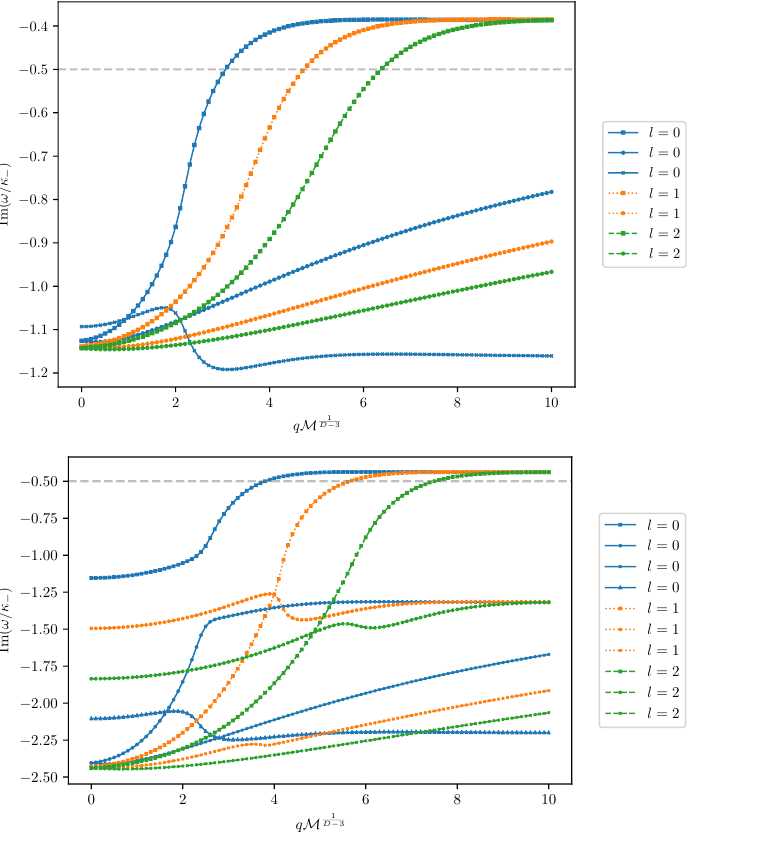
Figure 3 . The imaginary part of the low-lying quasinormal modes for (cid:3) the top is for and Q = 0 : 996 and the bottom is for Q Q max